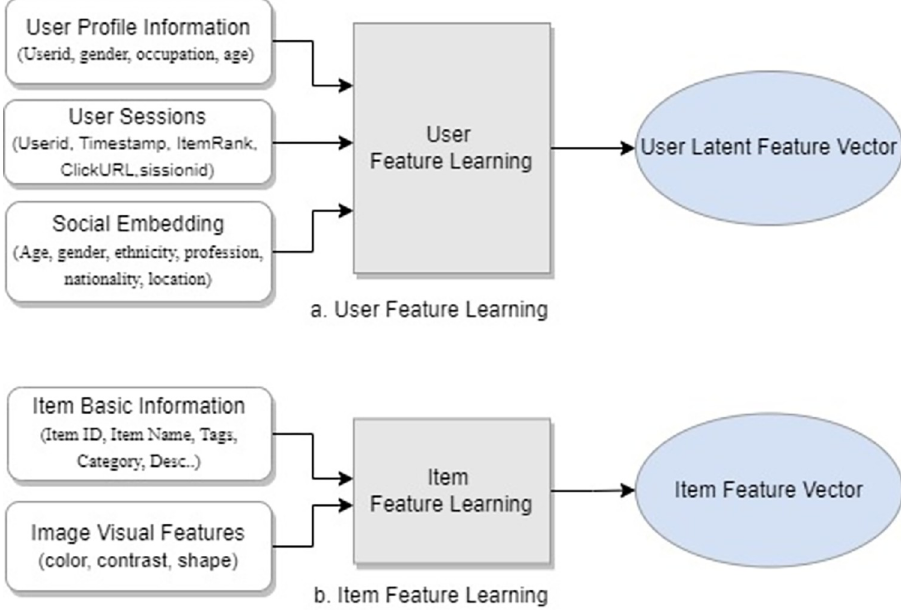
Fig 4. Multimodal embedding for feature learning. (a) User feature learning; (b) Item feature learning.